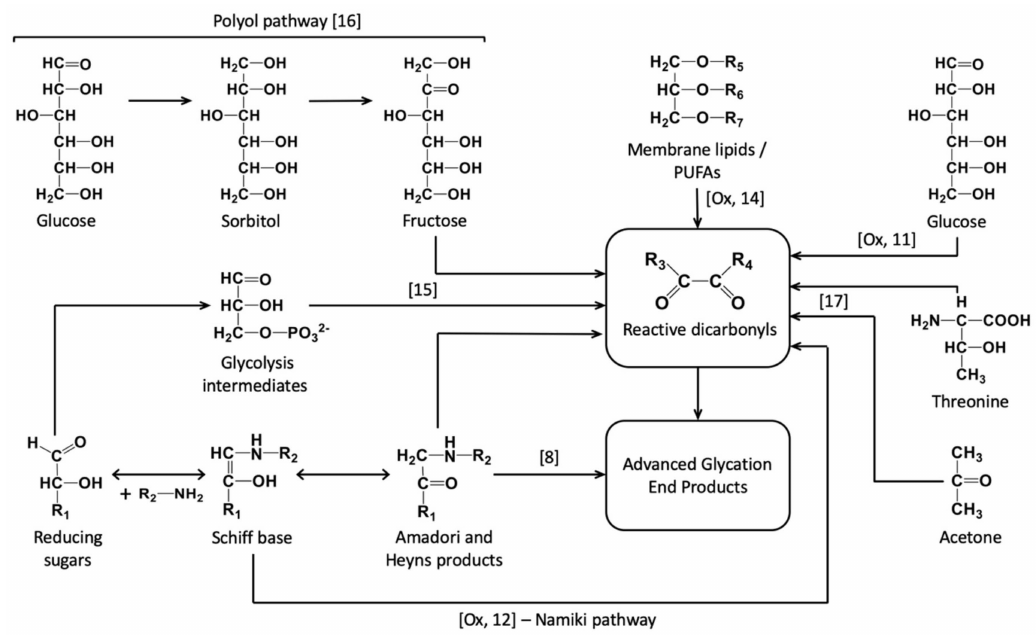
Figure 1. The main pathways of advanced glycation end product (AGE) formation in vivo: degradation of Amadori and Heyns products [8], lipid peroxidation [14], polyol pathway [16], monosaccharide autoxidation [11], oxidation of Schi ff bases [12], non-enzymatic conversion of glycolysis intermediates [15], acetone and threonine metabolism [17]. [Ox],